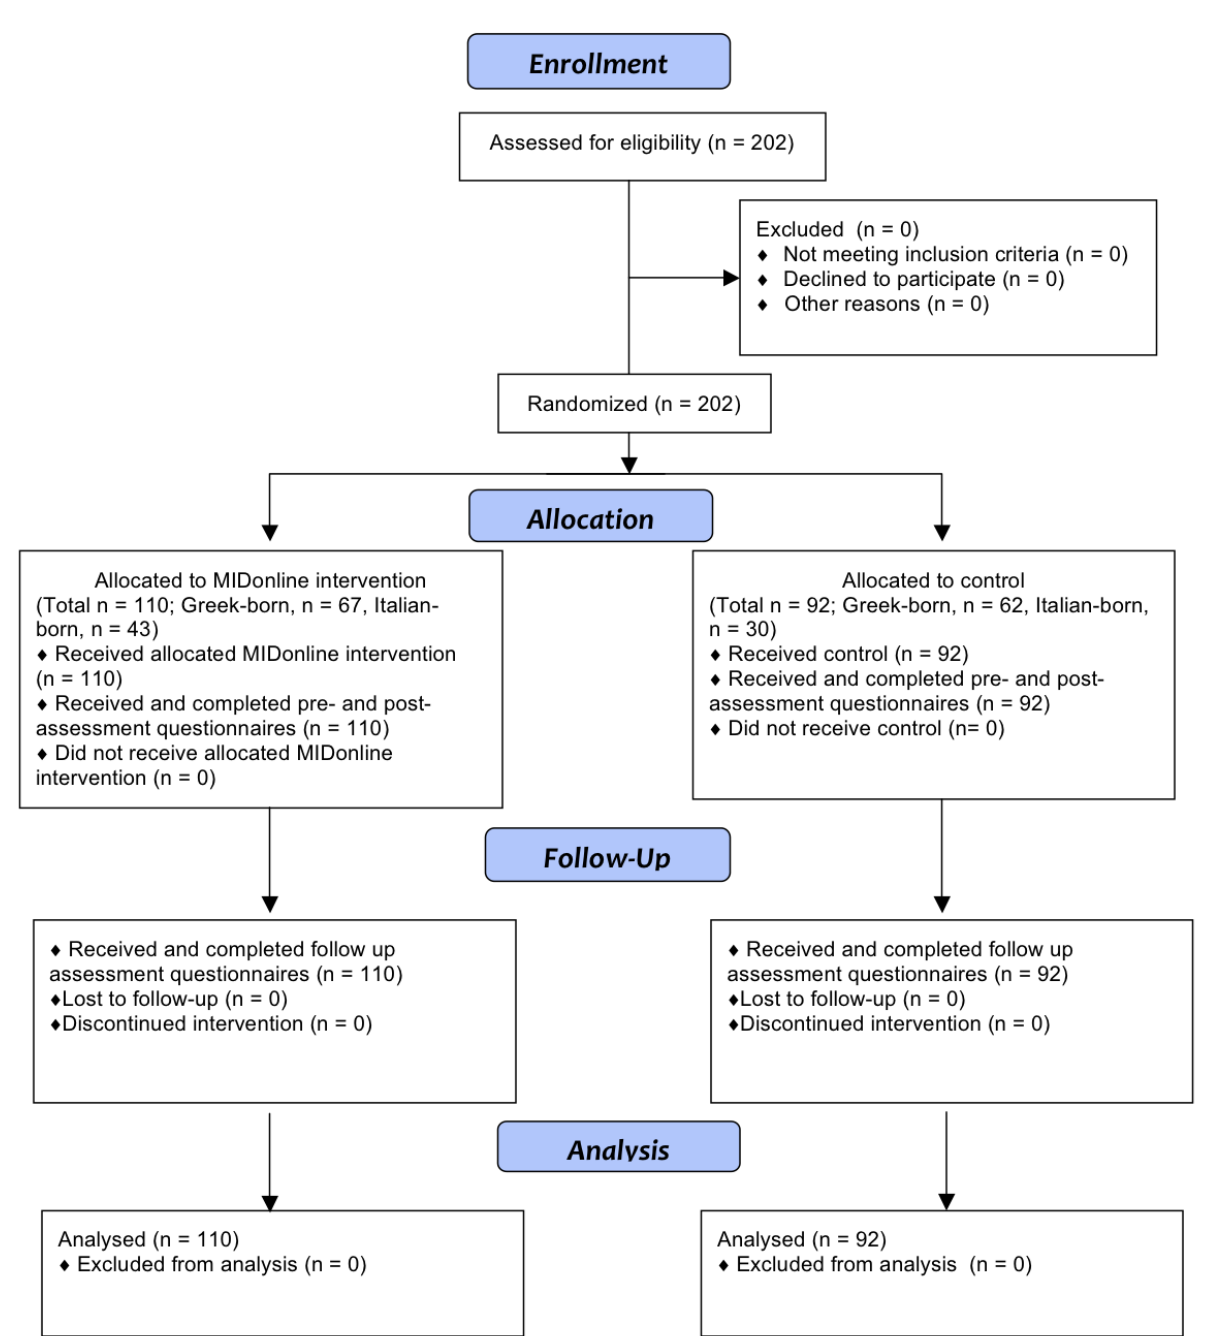
Figure 4. Flow of participants through research